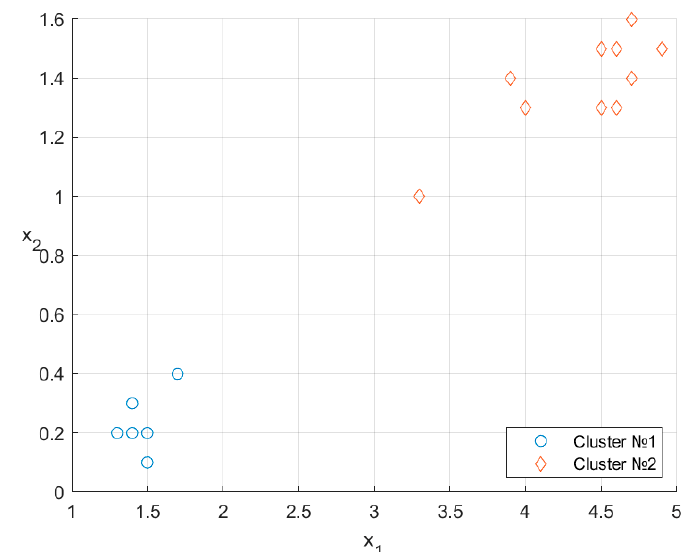
Figure 3. Randomized clustering results. A direct comparison with Figure 1 indicates a perfect match of 10/10: no clustering errors. Example 2. Consider another data matrix from the same dataset (Table